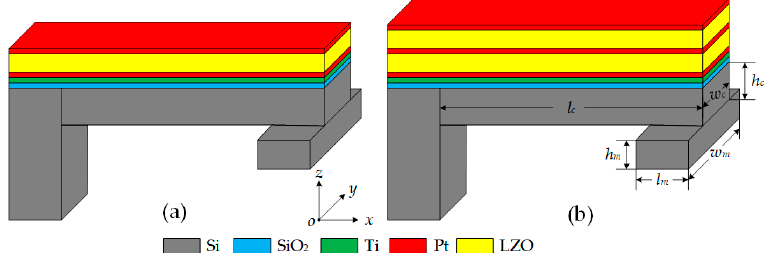
Figure 1. Basic structure of proposed acceleration sensor in two models: ( a ) Model I; ( b ) model